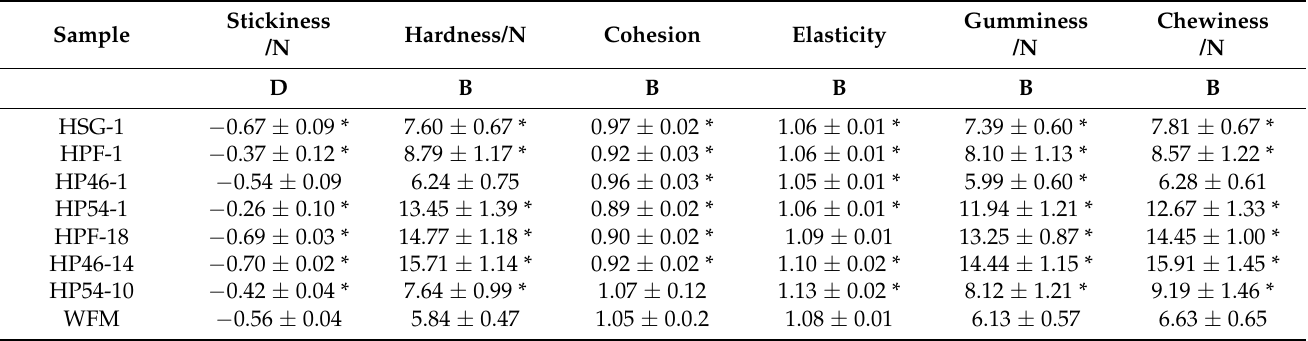
Figure 4. Scaled and centred biplots of colour ( a ) and texture ( b ) of samples. HSG—hemp seed grit; HPF—hemp press cake flour; HP46—hemp press cake flour protein (46%); HP54—hemp press cake flour protein (54%); WFM—half-and-half mixture of wheat and whole wheat flour. Table 3. Mean results of texture profile analysis with standard deviations of doughs (D) and breads (B). HSG—hemp seed grit; HPF—hemp press cake flour; HP46—hemp press cake flour protein (46%); HP54—hemp press cake flour protein (54%); WFM—half-and-half mixture of wheat and whole wheat flour. All samples were measured at least nine